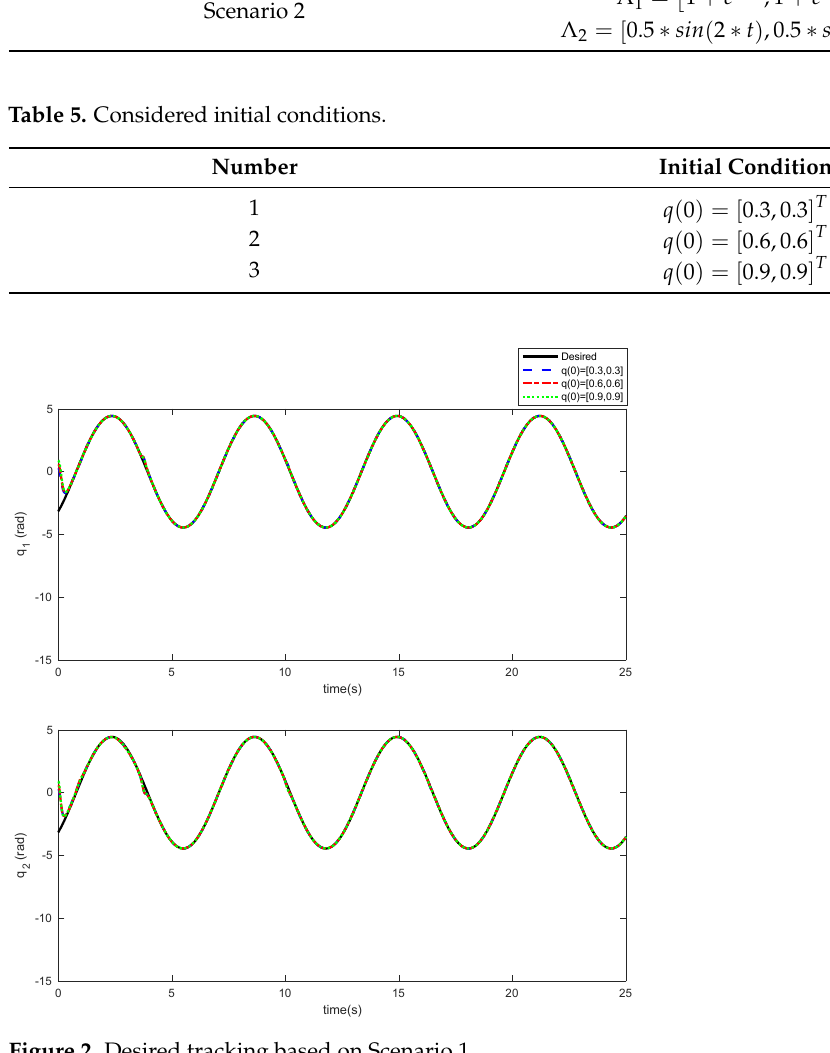
Figure 2. Desired tracking based on Scenario 1.